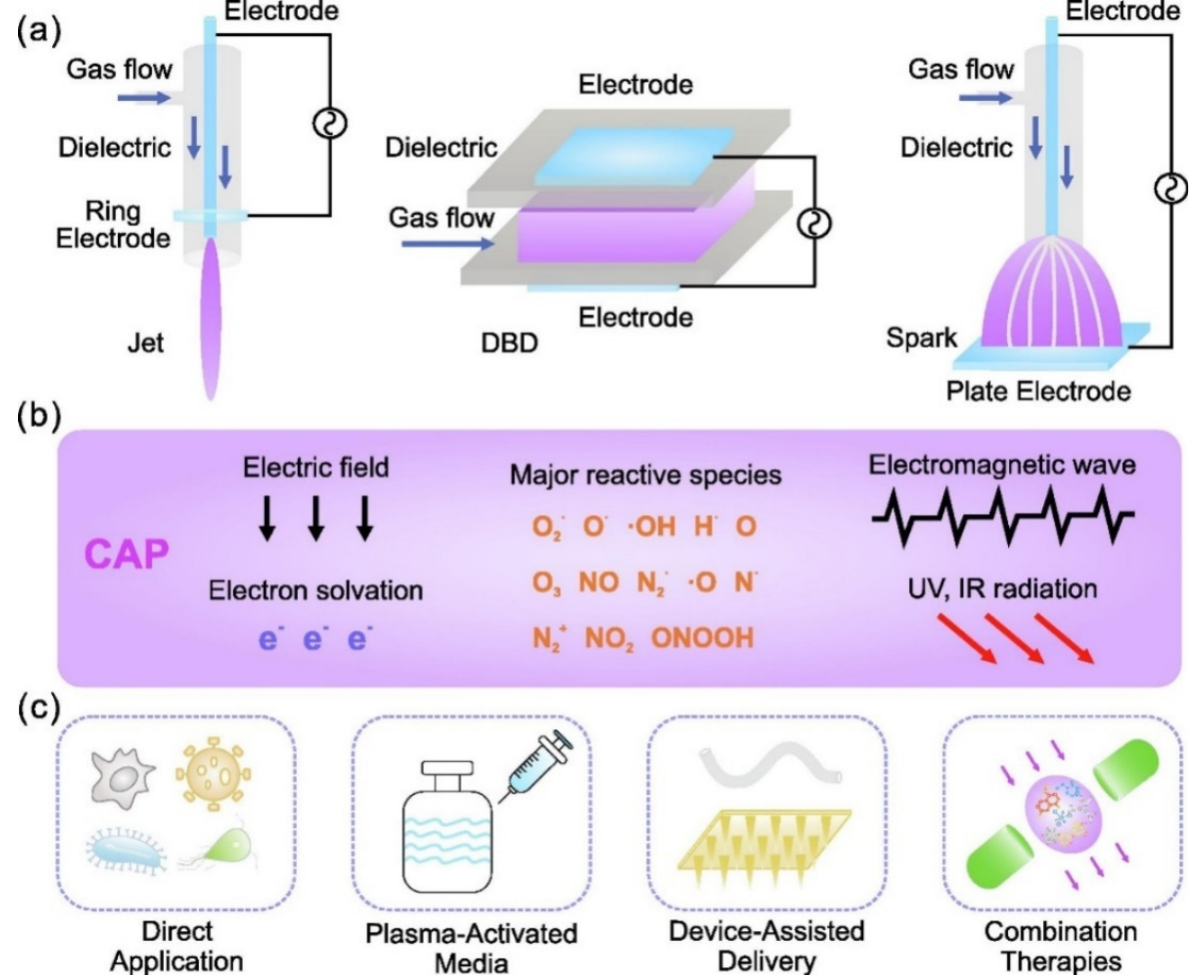
Figure 7. ( a ) Typical cold atmospheric plasma configurations for biomedical applications, such as plasma jet, dielectric barrier discharges (DBD), and spark; ( b ) plasma environment, which includes plasma generating reactive species, electrons, other ions, emissions, waves, and physical forces; ( c ) plasma delivery strategies, which include direct application, plasma-activated media, device-assisted delivery, and a combination of these. Reproduced with permission from [116]. Copyright 2022, Elsevier.